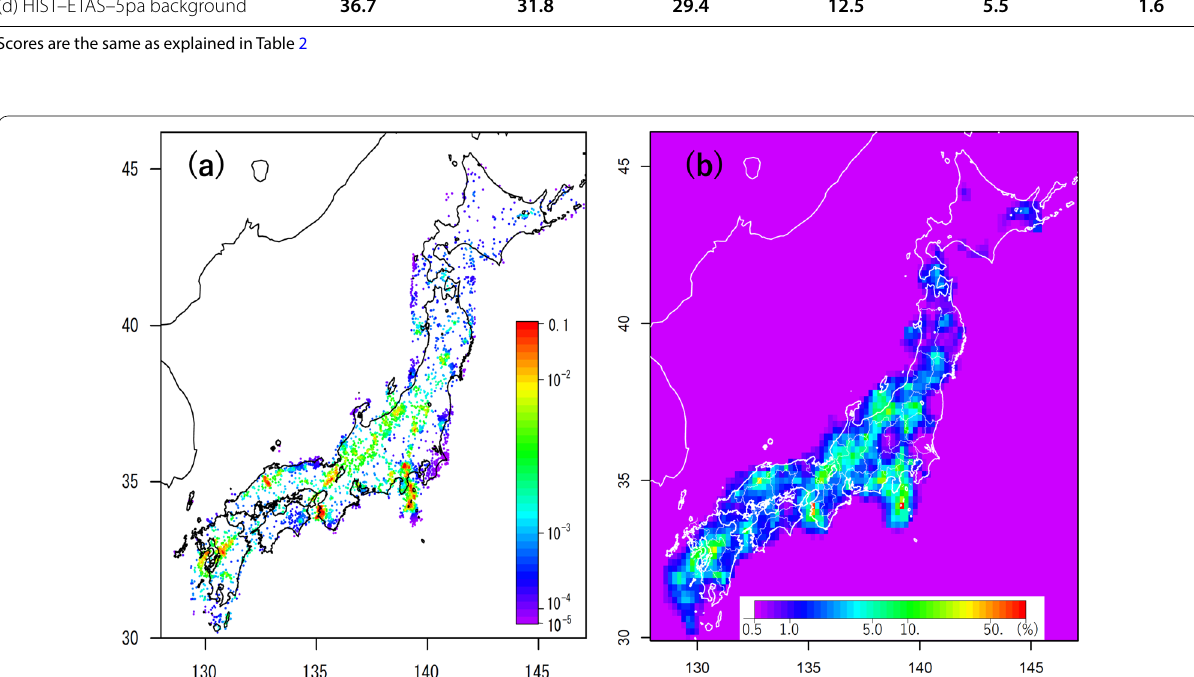
4 . 0 in and around ≥ =